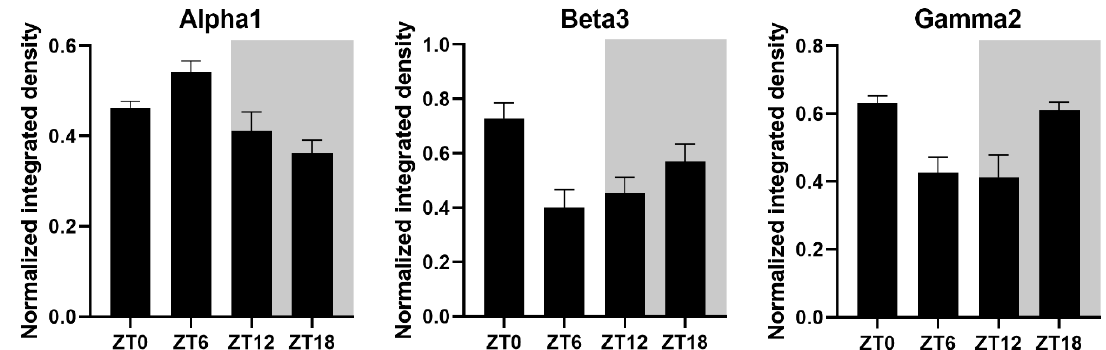
Figure 3. Quantification of GABA A R α 1, β 3, and γ 2 subunit immunoreactivity in the mouse SCN from mice maintained in a light-dark cycle (LD 12:12). Timing of the light and dark portions of the day are indicated by the white and grey backgrounds respectively. The data are graphed as mean density of staining normalized to peak staining (as 1.0) ± SEM.